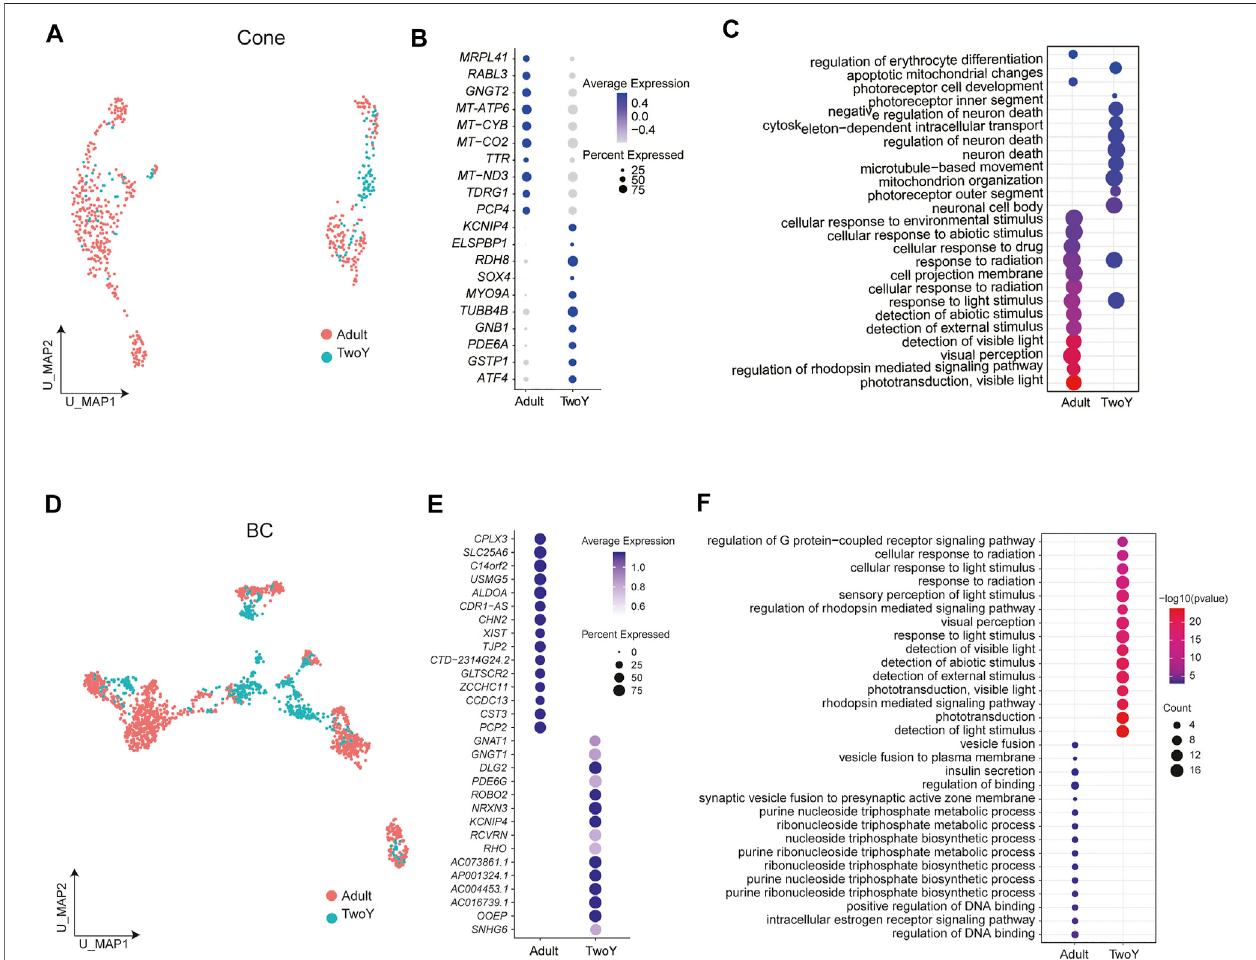
FIGURE 7 | Comparison of BCs and cone PRs between the retinas of adults and young children. (A) A UMAP map of reference adult data and TwoY data among cone PRs, separated by data source. (B) Different expression patterns of cone PR markers in adults and young children. Dot size represents the percentage of cells expressing corresponding genes and color represents the expression levels. (C) A Dotplot shows functional enrichment of genes with signi fi cant differential expression between the cone PRs of adults and young children. (D) A UMAP map of reference adult data and TwoY data within BCs, separated by data source. (E) Different expression patterns of BC markers in adults and young children. Dot size represents the percentage of cells expressing corresponding genes and color represents the expression levels. (F) A Dotplot shows functional enrichment of genes with signi fi cant differential expression between the BCs of adults and young children.